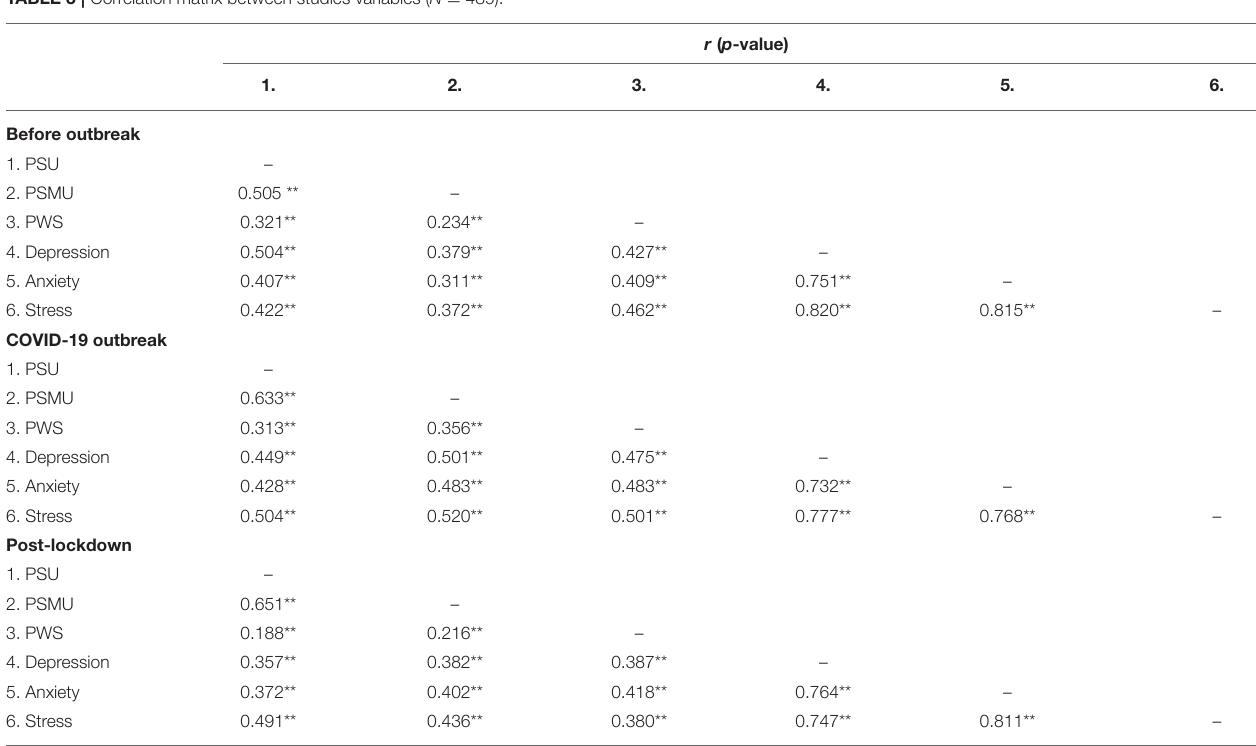
TABLE 3 | Correlation matrix between studies variables ( N =